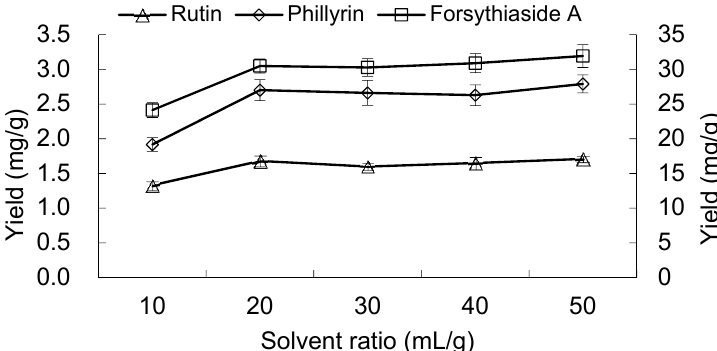
Figure 6. Effect of solvent to material ratio on the extraction yields of forsythiaside A, phillyrin and rutin. The value of forsythiaside A is shown on the secondary y -axis on the right.